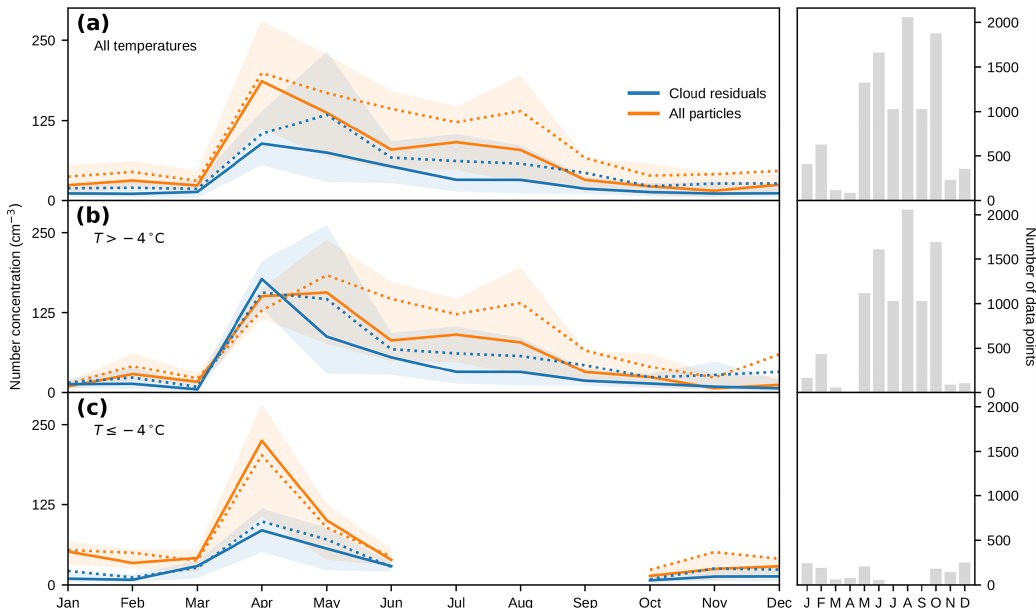
Figure 7. Annual cycle of total and cloud residual number concentrations. Monthly averages of total (orange) and residual (blue) particle number concentrations integrated above 20nm, measured at Zeppelin Observatory, Svalbard, during the period November 2015–February 2018. Solid and dotted lines show median and mean values, respectively, and shaded areas indicate the 25th to 75th percentile ranges. Data have been segregated based on the temperature at the station, T . The panels show data for (a) all T , (b) T > − 4 ◦ C, and (c) T ≤ − 4 ◦ C, and the corresponding bar charts show the number of data points per